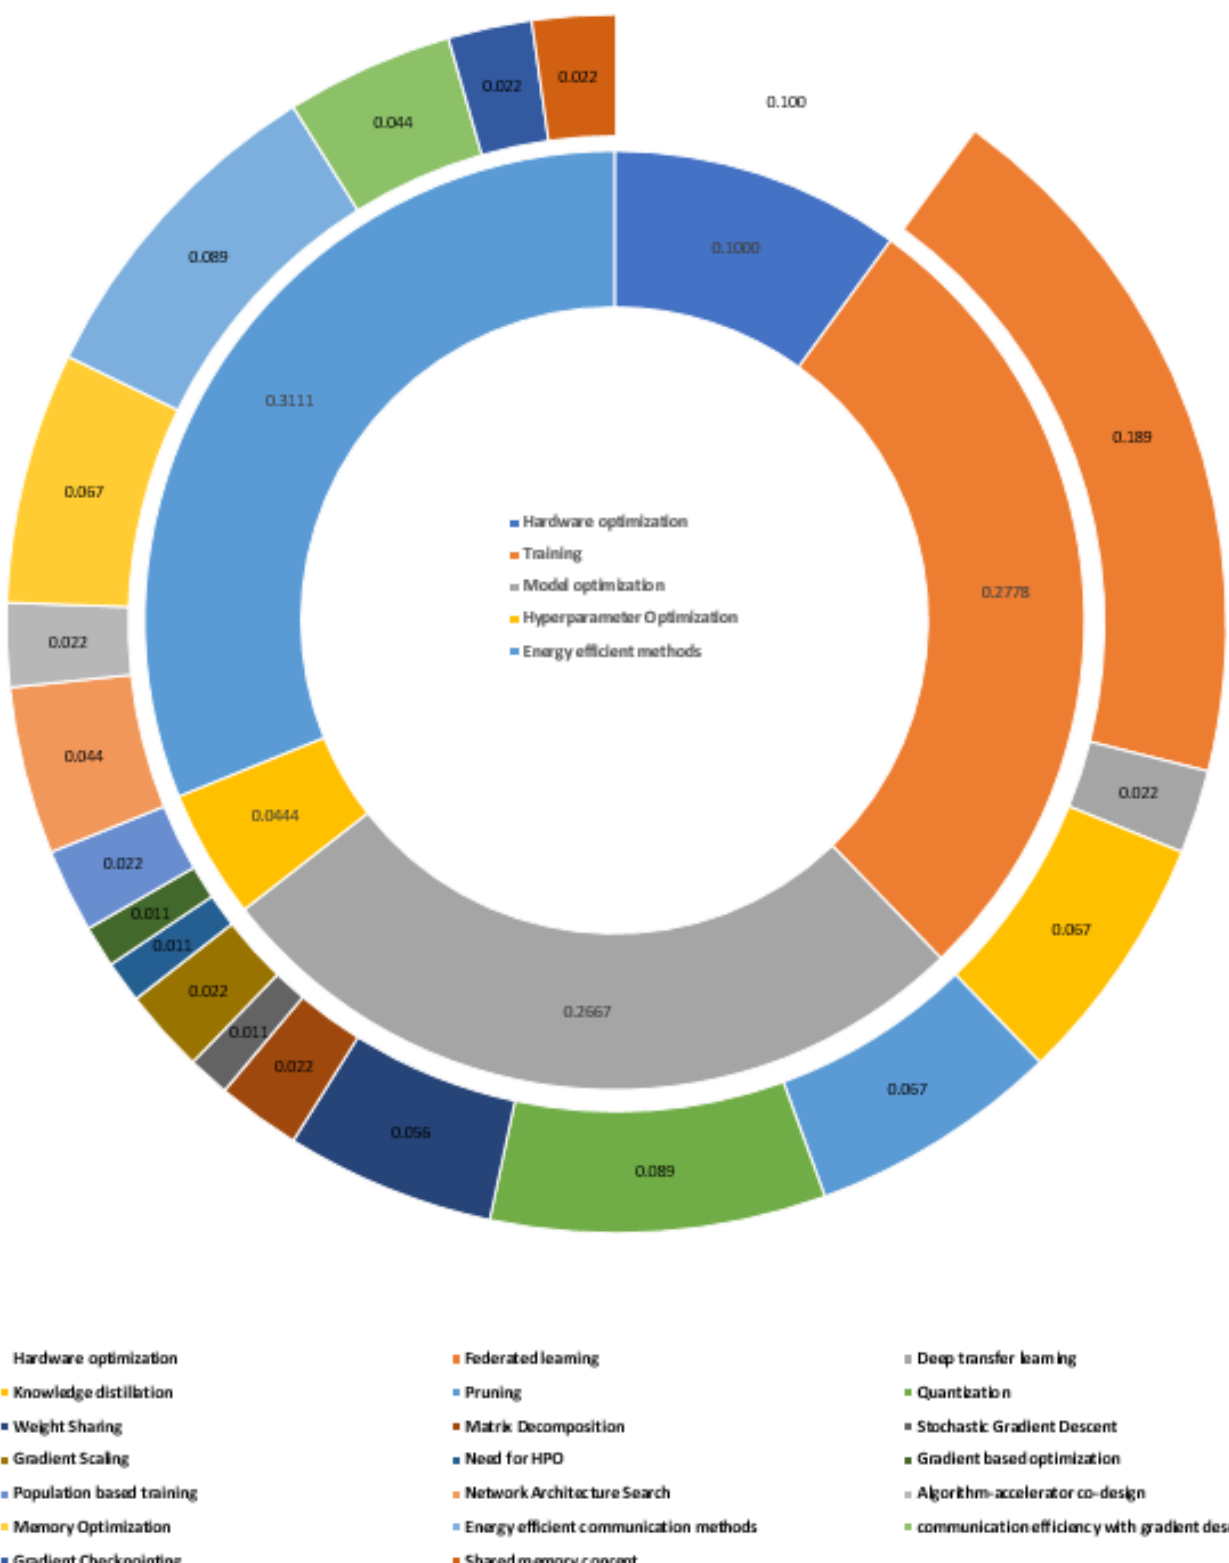
Figure 5. Graph denoting the major and sub categories of publications.